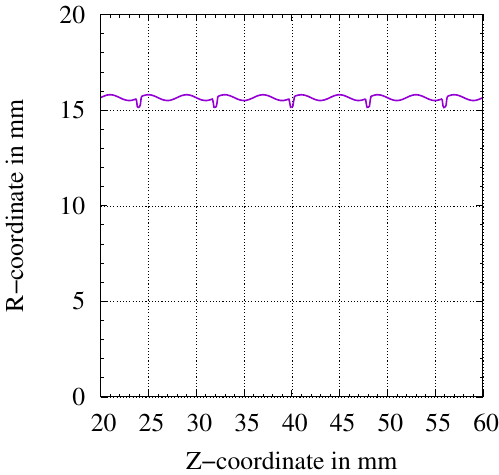
Figure 7. Surface contour of verification example with rough surface at time t =